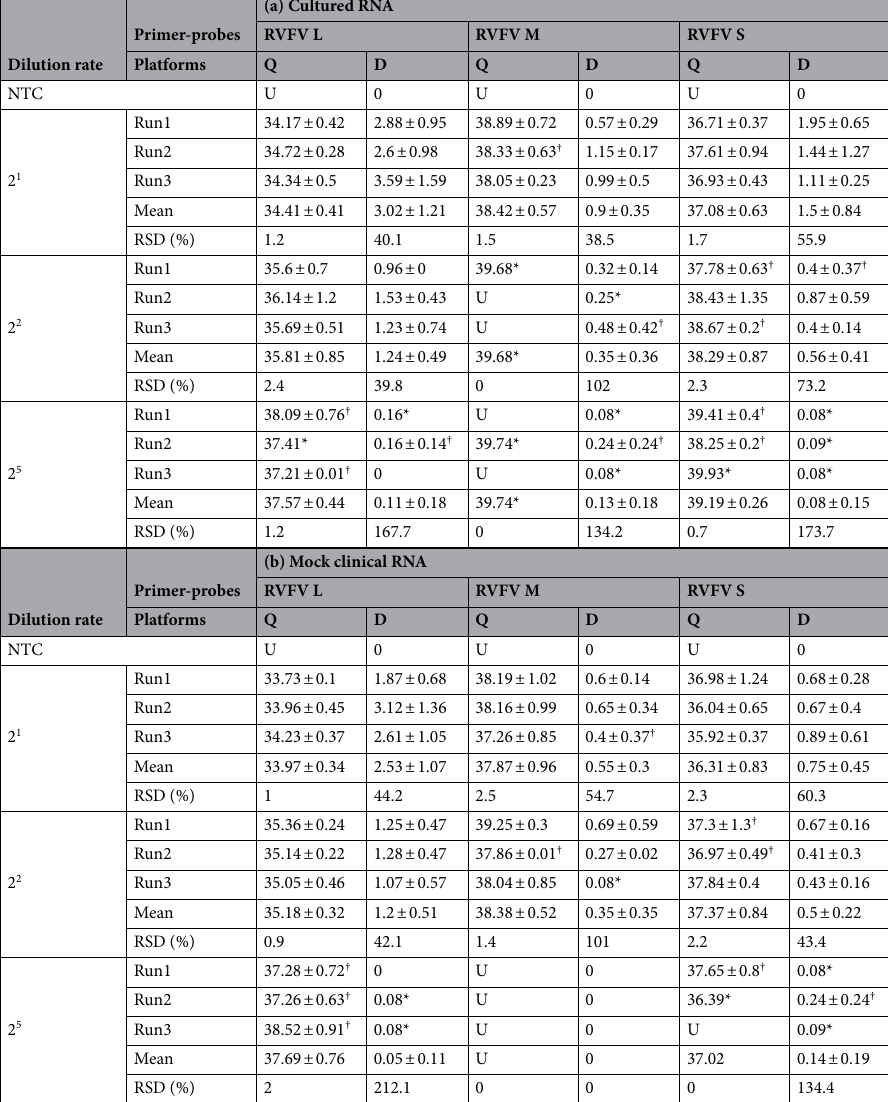
Table 3. Limit of Detection (LoD) of the cultured RVFV RNA by RT-qPCR and RT-ddPCR with the L, M and S segment assay. Each run represents the mean of three replicates within an independent run. *Only one of three replicates were positive. † Only two of three replicates were positive. The ‘U’ indicates underdetermined. The ‘Q’ indicates RT-qPCR, and the unit is ‘Ct value’. The ‘D’ indicates RT-ddPCR, and the unit is